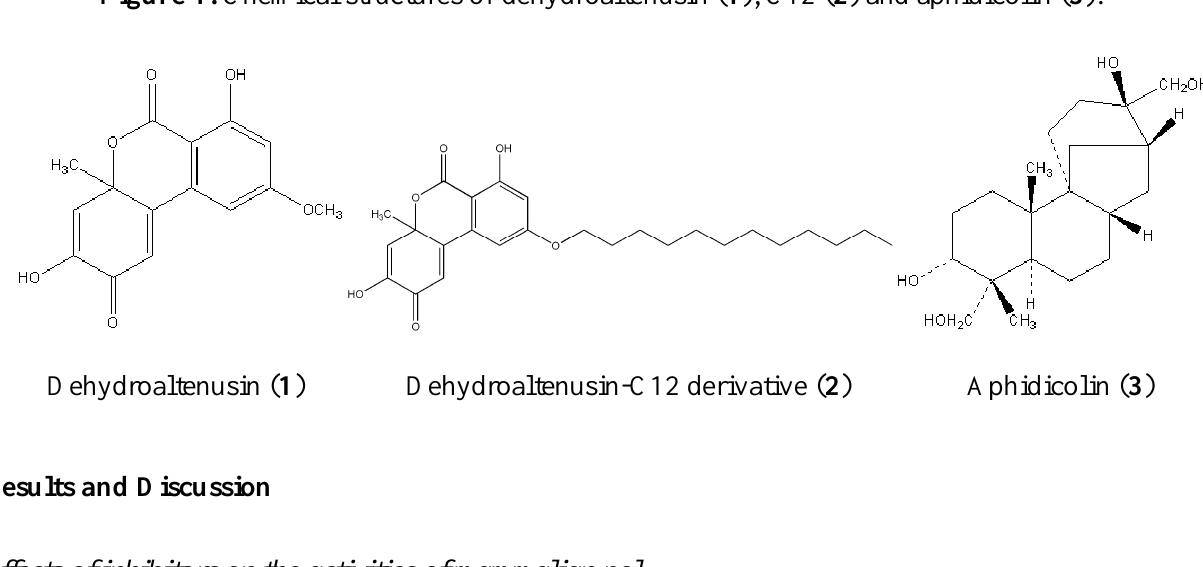
Figure 1. Chemical structures of dehydroaltenusin ( 1 ), C12 ( 2 ) and aphidicolin ( 3